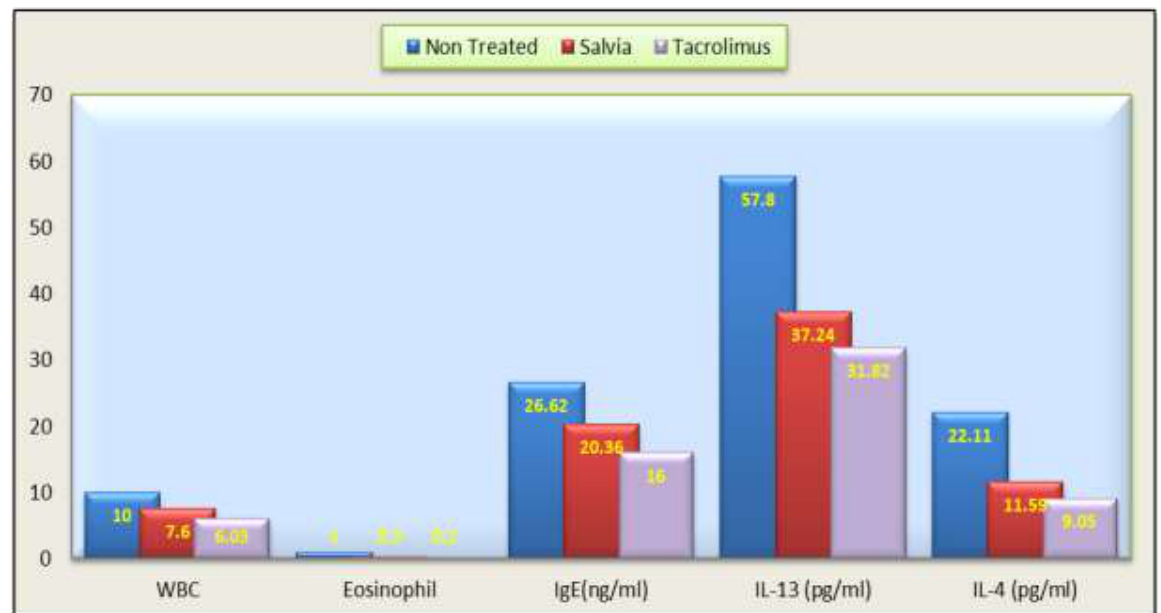
Figure 7. Comparison between non treated atopic dermatitis induced group with each of Salvia frigida and Tacrolimus treated groups (by one way ANOVA test) regarding WBC, Eosinophil, serum IgE, and skin tissue homogenate of IL-4 and IL-13. WBC: white blood cells, IgE: immunoglobulin E, IL-13: interleukin 13, IL-4: interleukin 4. Results are expressed as mean ± SD, P is significant at ≤ 0.05.